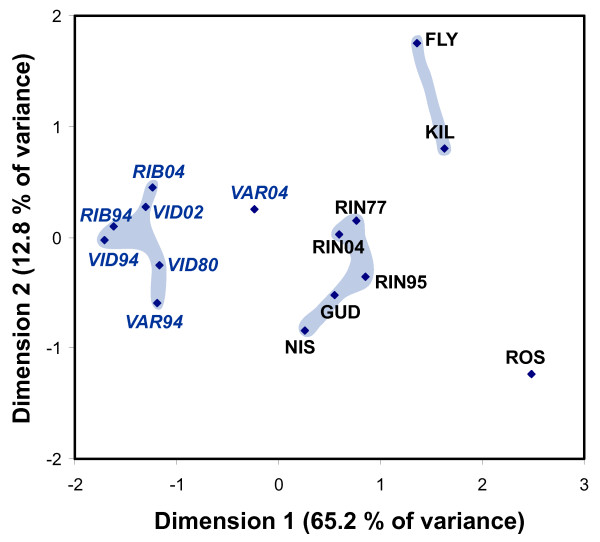
Multidimensional scaling plot of genetic relationships among samples. Multidimensional scaling plot based on pairwise θST between samples. Samples of North Sea houting are denoted by blue print. See Table 1 for a list of sample abbreviations.